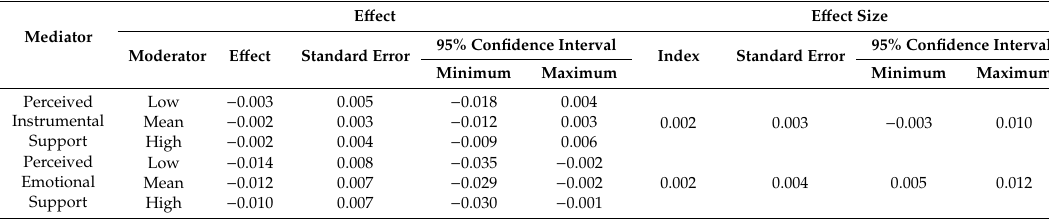
Table 5. Bootstrapping tests for mediated moderation e ff